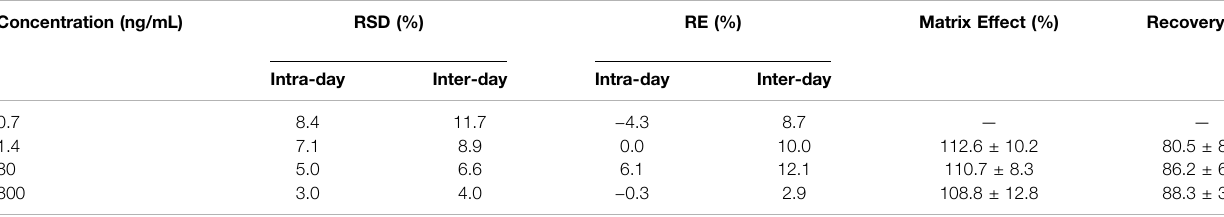
TABLE 1 | Accuracy, precision, matrix effect and recovery of QC samples of relugolix from plasma in rats ( n = 6). Concentration